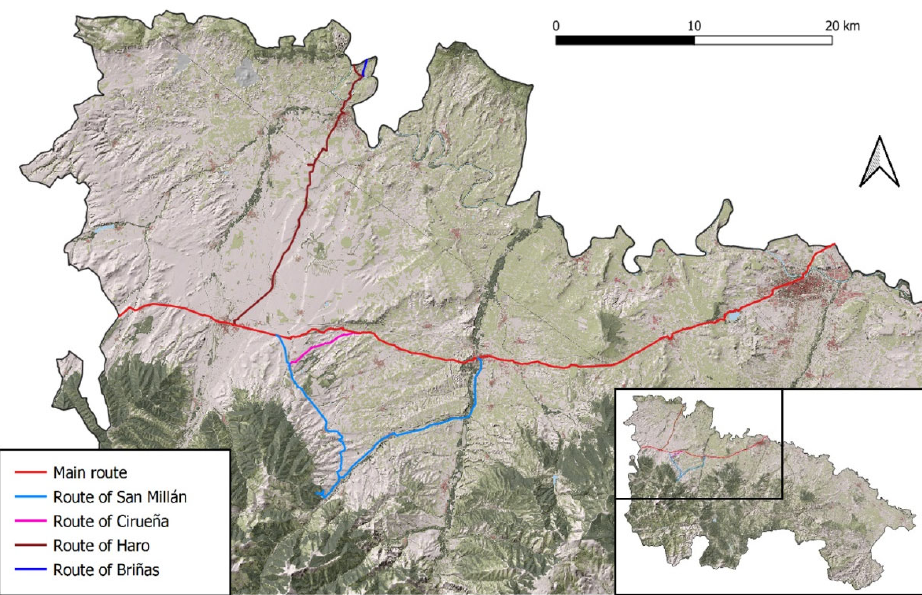
Figure 3. Way of Saint James through La Rioja